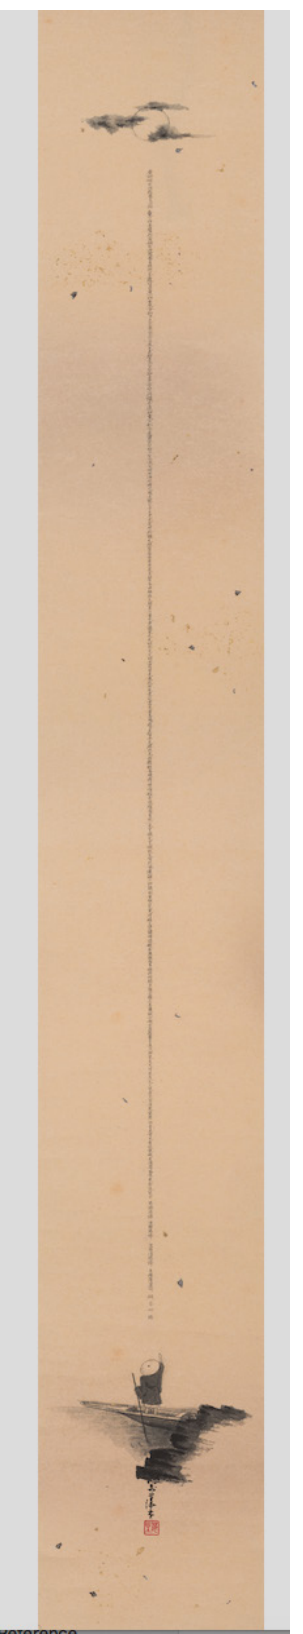
Figure 1 . Moonbeam, by Iwasaki Tsueno (courtesy of Professor Paula